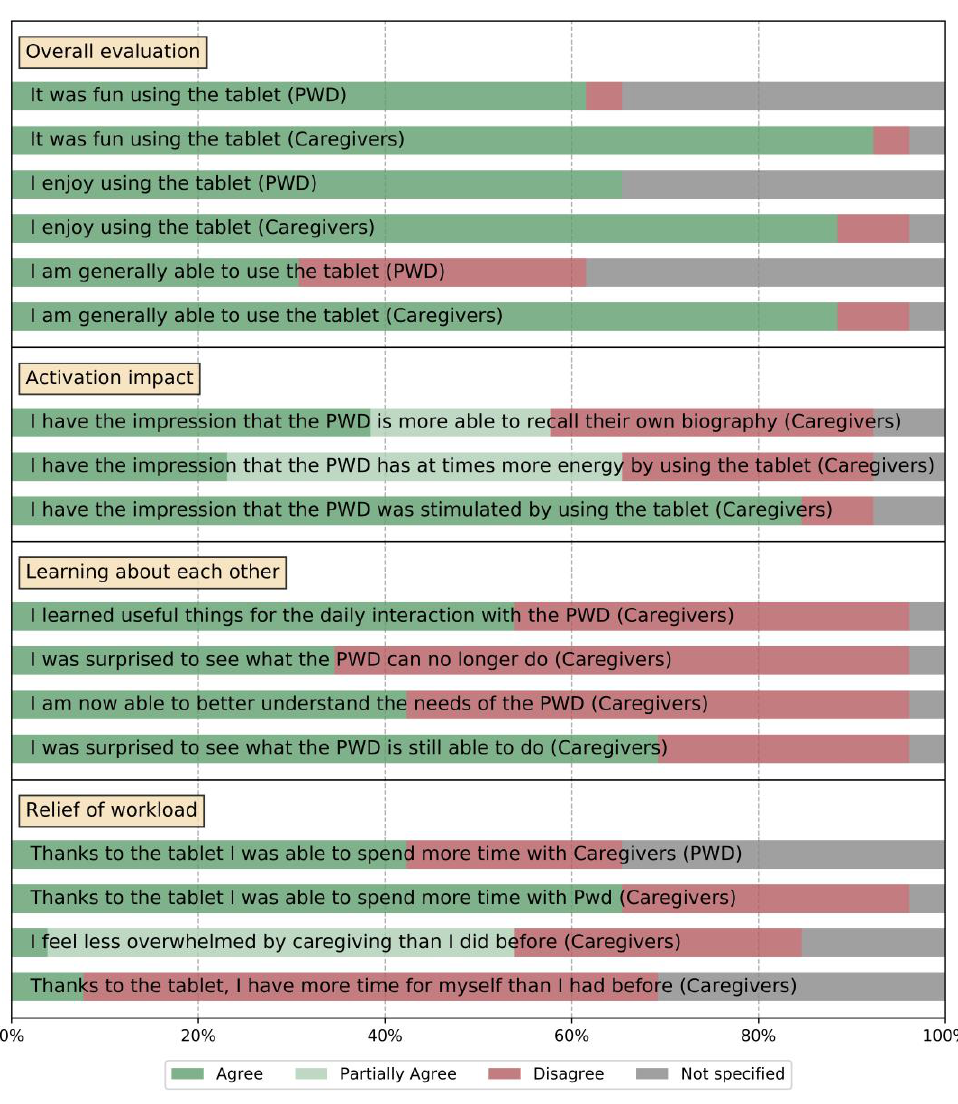
Figure 10. Responses to final questionnaire at the end of the evaluation ( n = 25) for persons with dementia (PwD) and Caregivers.